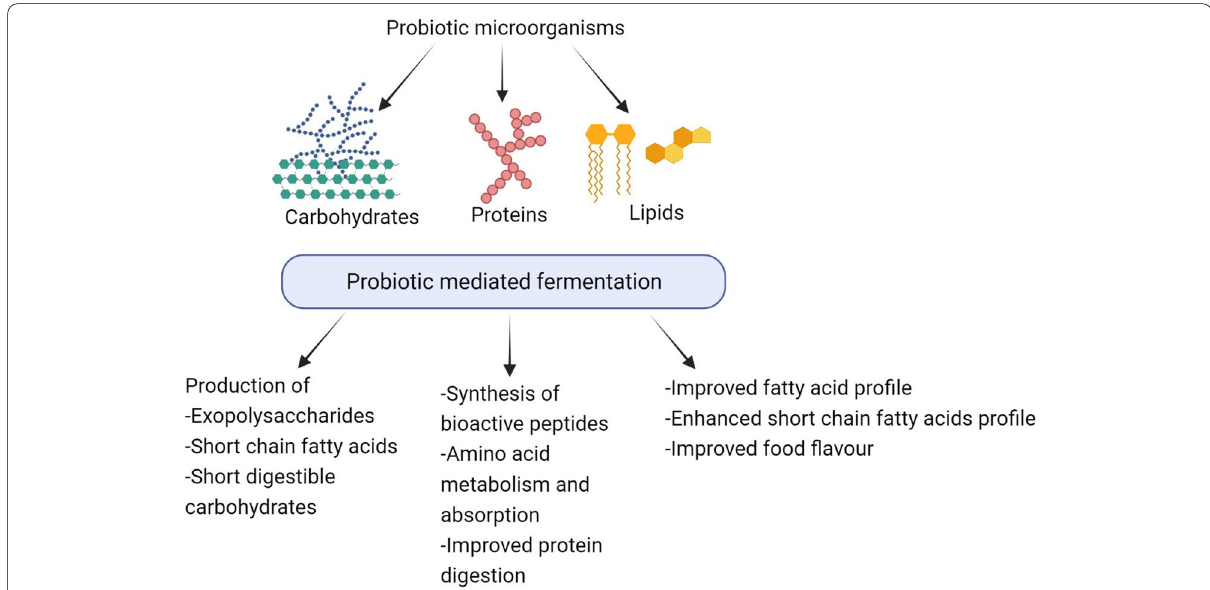
Fig. 1 Effect of probiotic bacteria on the fermentation of macronutrients present in the